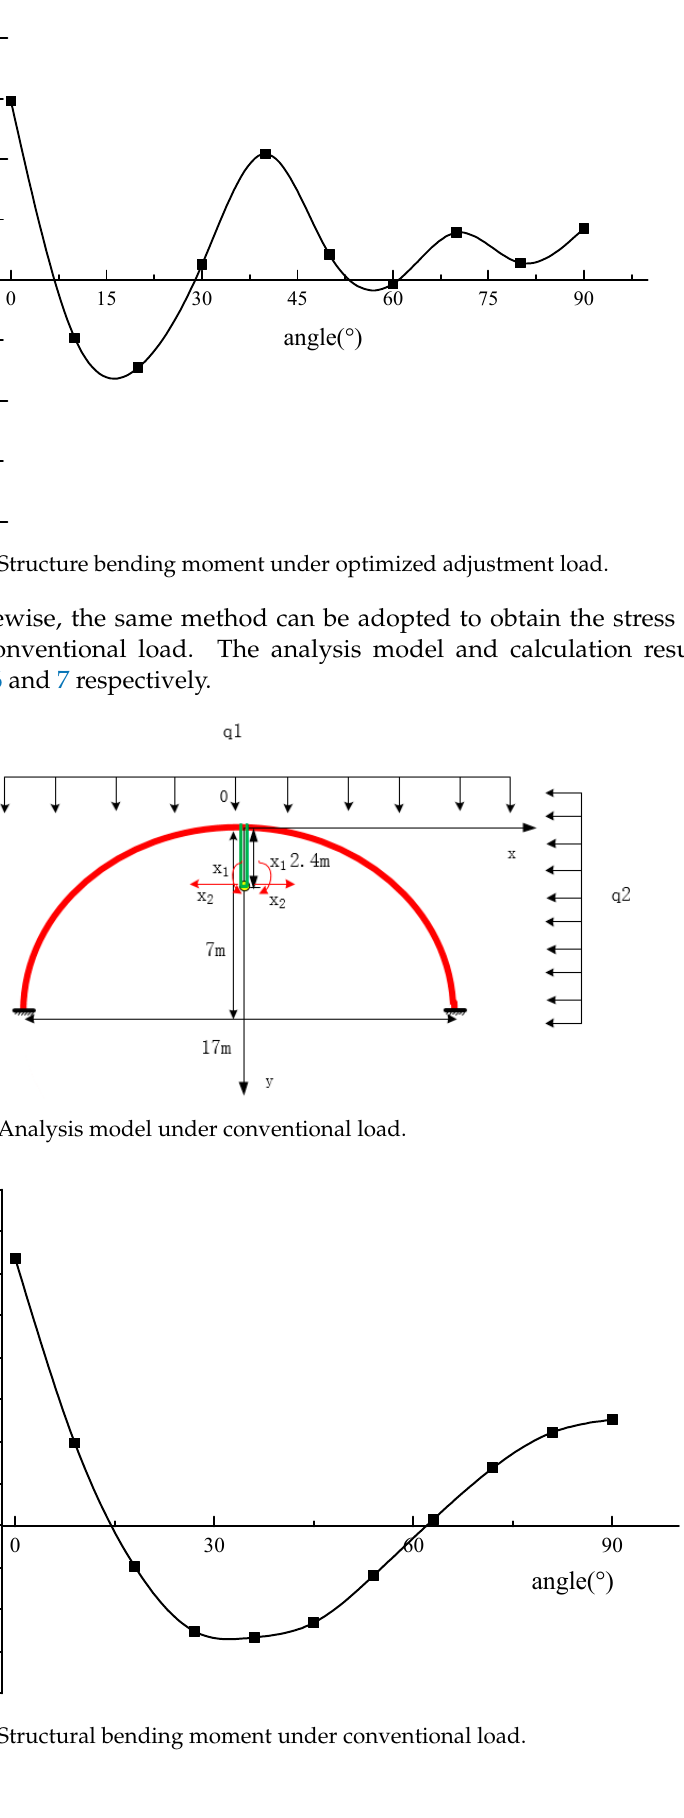
Figure 4. Bending moment distribution caused by unit adjustment load.